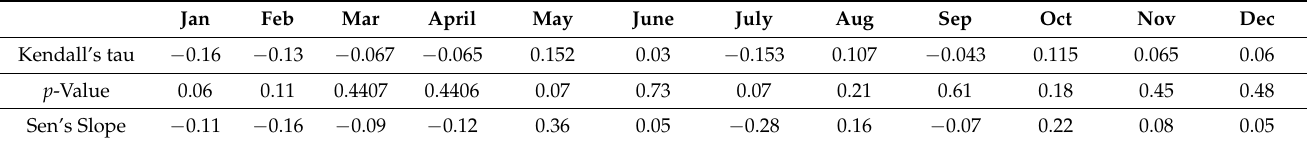
Table 2. Monthly rainfall trend analysis results of Ethiopia (1958–2020)